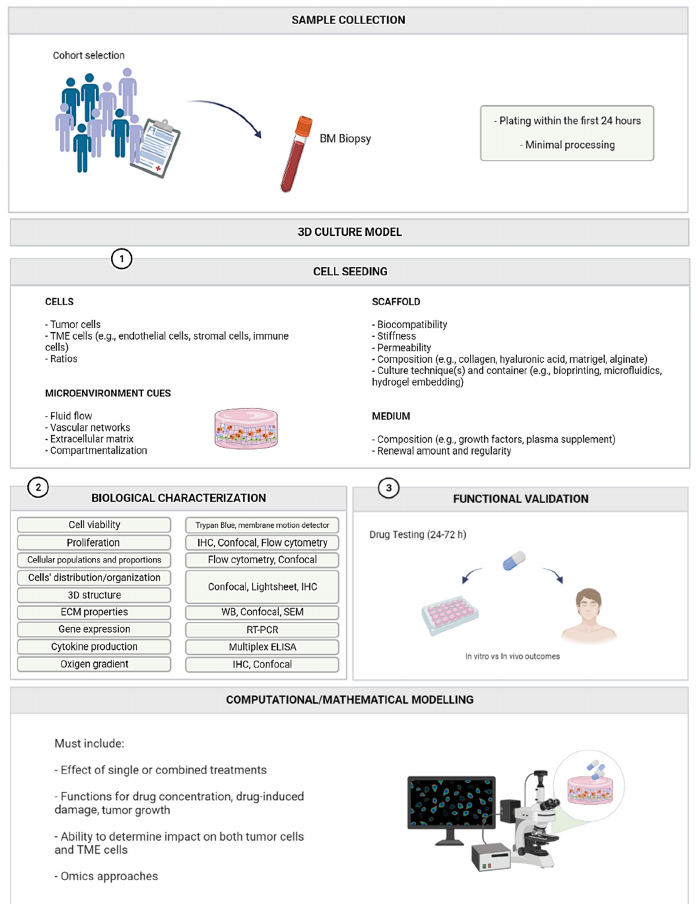
Figure 2. Key points for obtaining the ideal 3D MM model. Even though efforts to create an authentic and reliable MM model are increasing, there are still issues that need to be addressed and improved. Here, we sum up the main factors and variables that are essential and must be considered before, during and after developing a 3D MM model. They include sample processing, culture establishment, biological assays, validation and prediction of clinical outcomes. Created with BioRender.com. Abbreviations: BM, bone mar- row; ECM, extracellular matrix; ELISA, enzyme-linked immunosorbent assay; IHC, immunohistochemistry; RT-PCR, reverse transcriptase polymerase chain reaction; SEM, scanning electron microscope; TME, tumor microenvironment; WB, Western